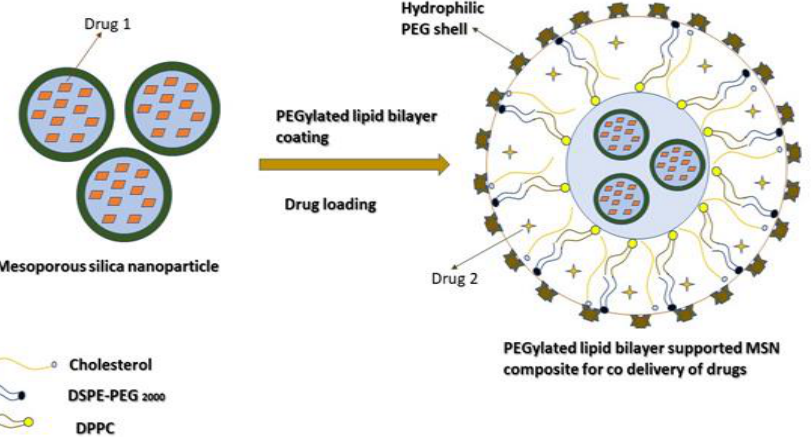
Figure 5. Representative picture of polymeric coating of MSN.